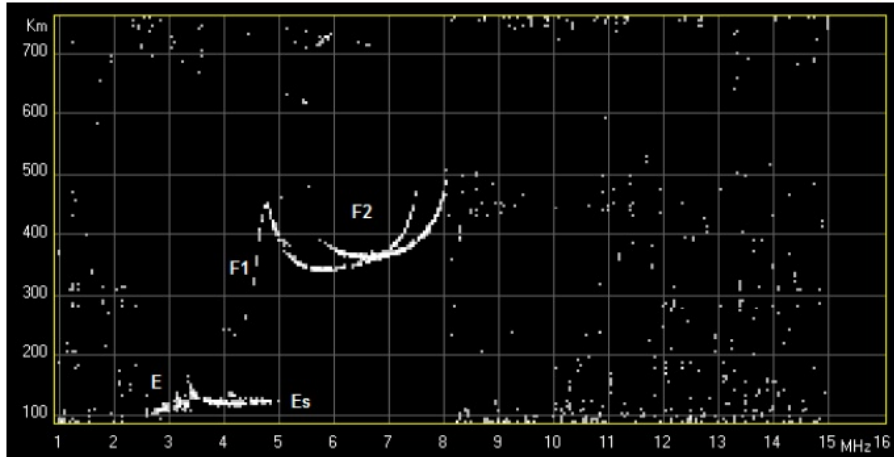
Figure 6. An example of an ionogram recorded by the VIS at the ASJI where one can see clearly the particular layers of the